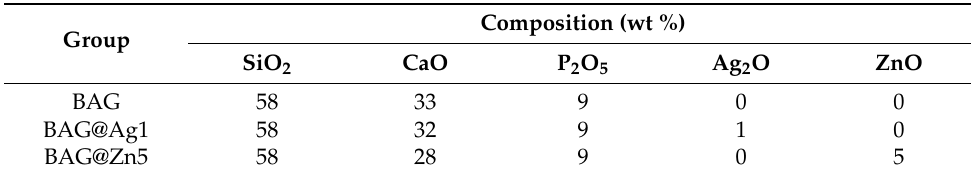
Table 3. Composition of the ion-doped bioactive glass.